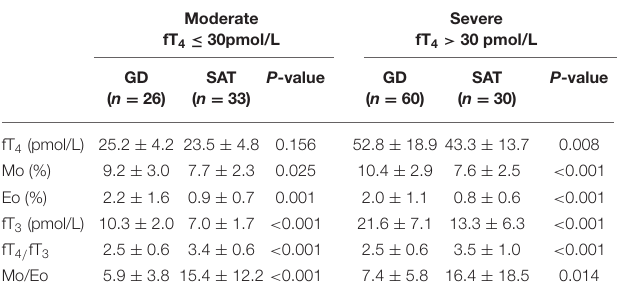
TABLE 1 | Clinical characteristics of the study population. Healthy control